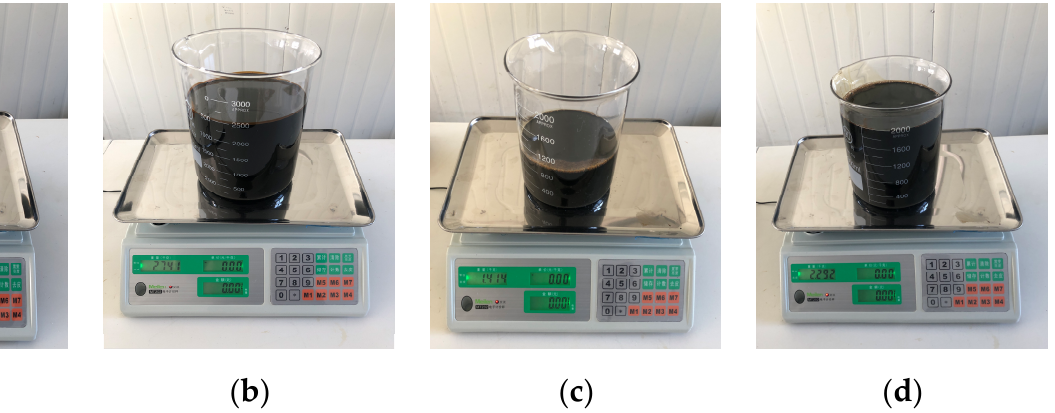
Figure 6. Measuring the quality of the experimental oils. ( a , b ) are the process of crude oil measurement. ( c , d ) are the process of fuel oil measurement.